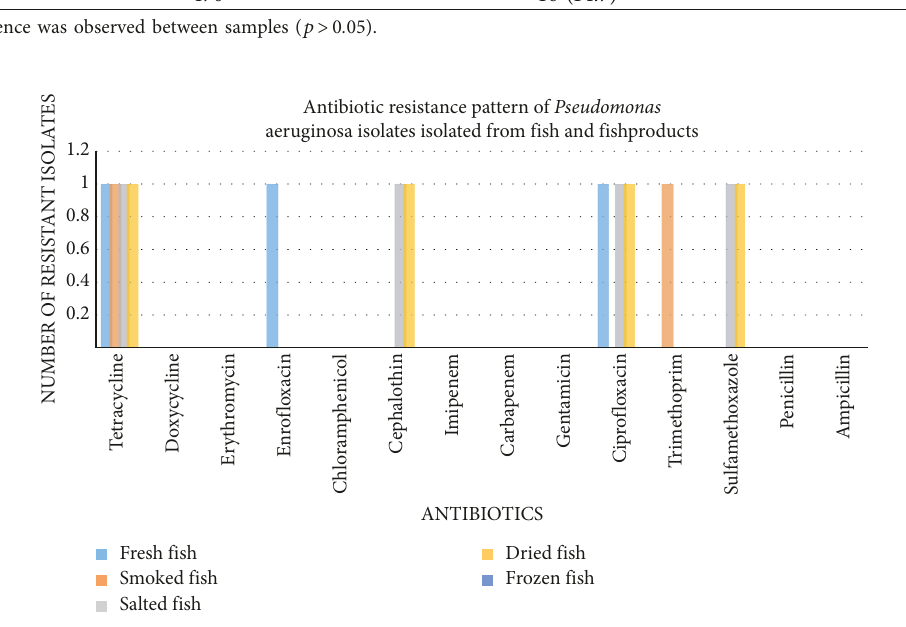
Figure 1: The number of resistant isolates of antibiotic resistance pattern of Pseudomonas aeruginosa isolates isolated from fish and fish